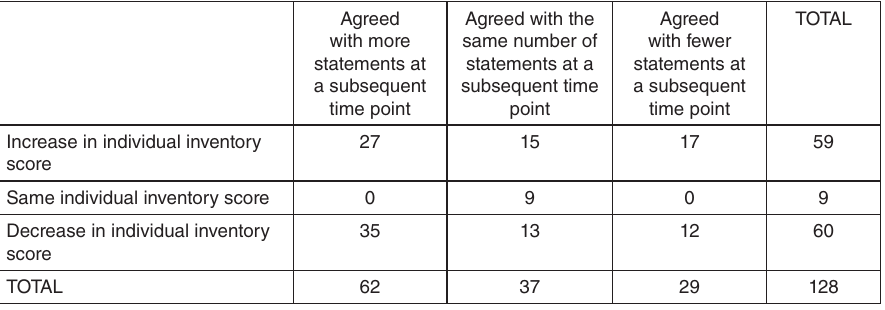
Table 6: Changes in the number of statements with which participants agreed and effect on individual inventory